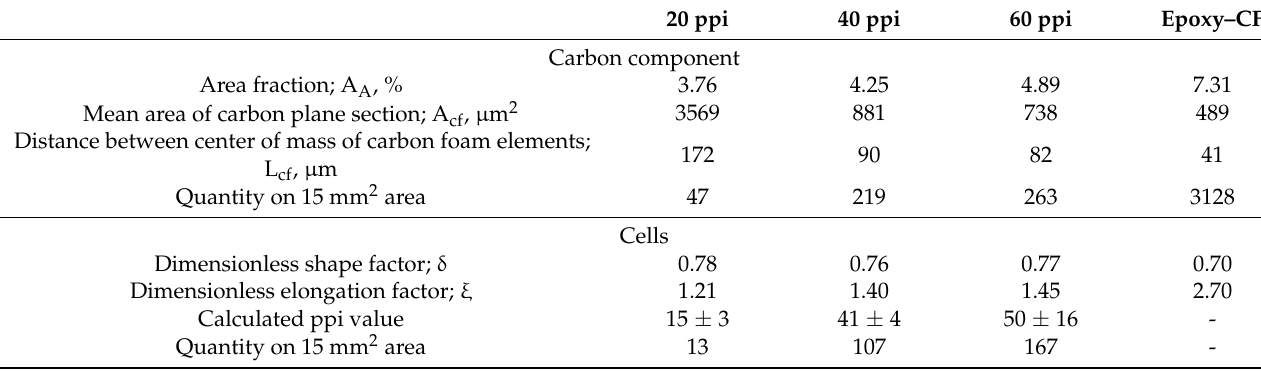
Table 1. Calculated stereological parameters of examined